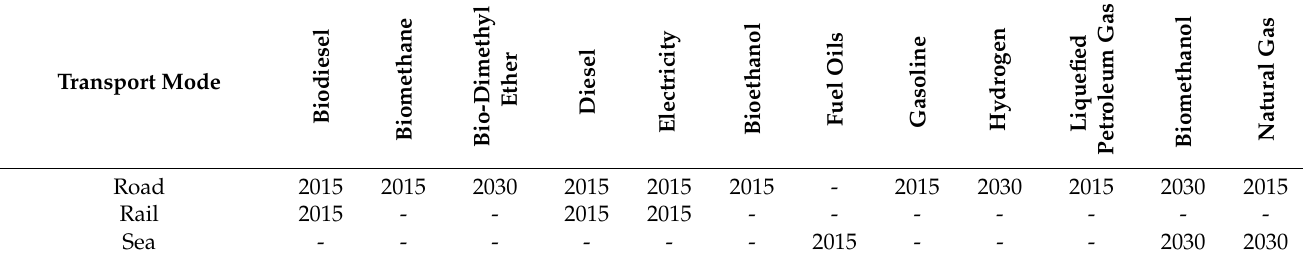
Table 1. TIMES-City fuel portfolio and current/assumed prospective year of availability per fuel option and transport mode.